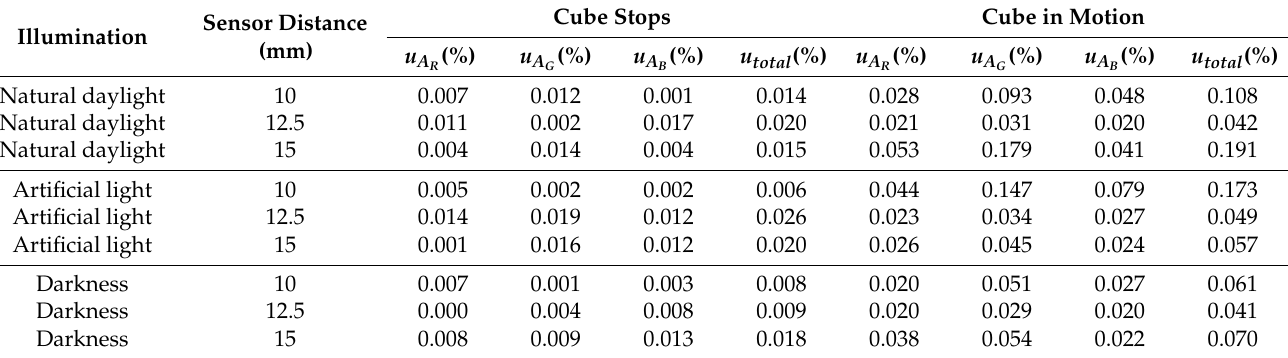
Table 7. Type A standard uncertainty for a green cube.